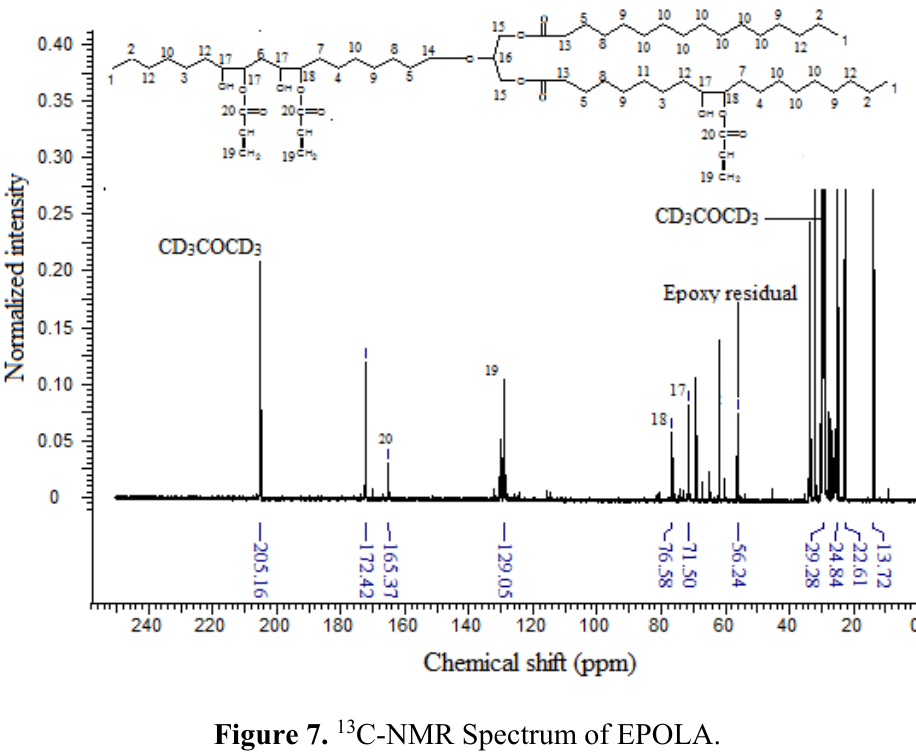
Figure 7. 13 C-NMR Spectrum of